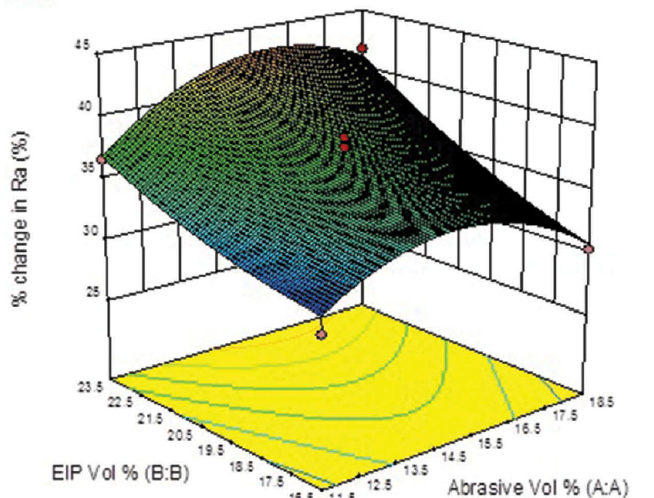
Figure 6. The BEMRF process.